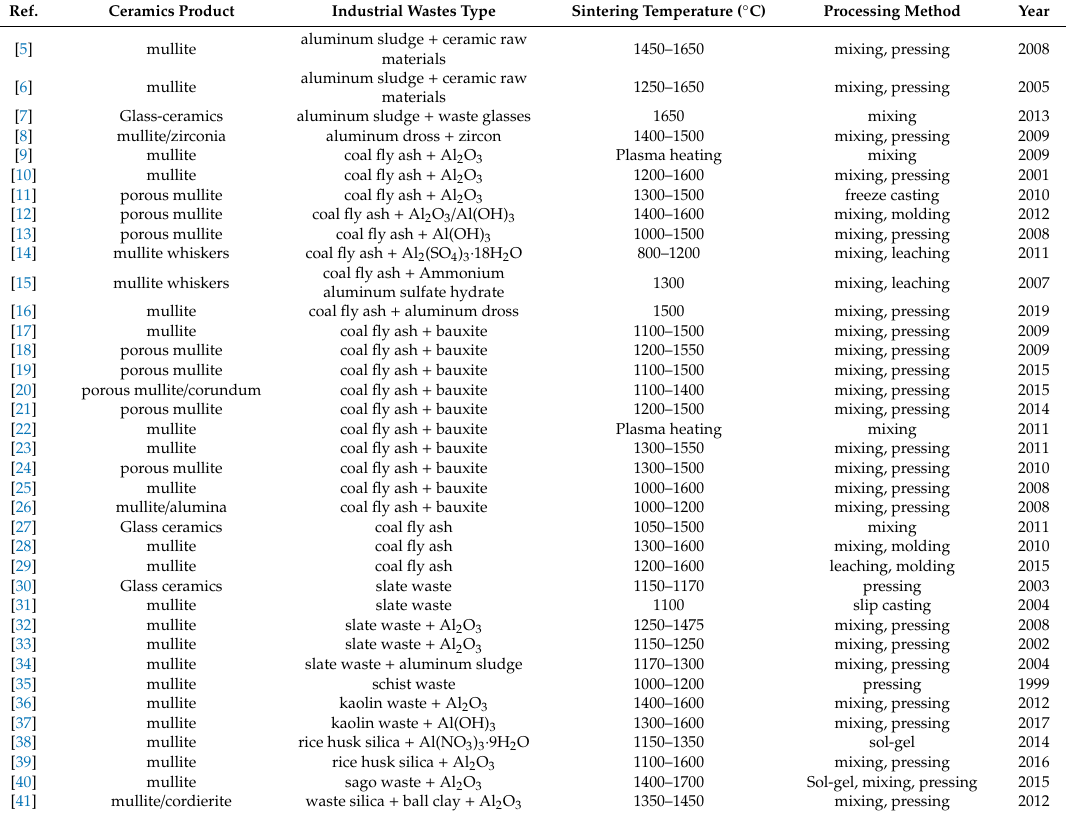
Table 1. Summary of key studies that using di ff erent types of industrial wastes to produce mullite.